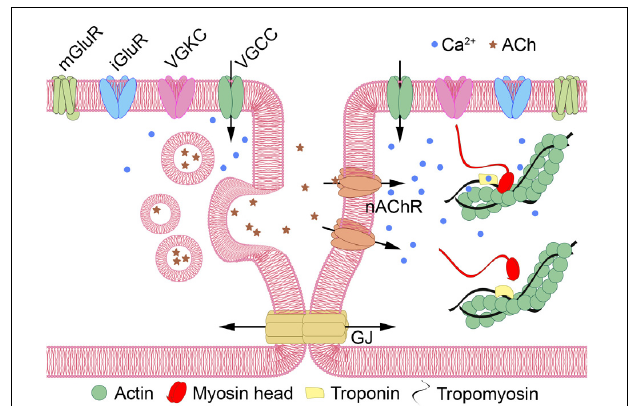
FIGURE 9 | Hypothetical schema of intercellular communication in Dicyemida. Dicyemids have no recognizable neurons and muscles, and yet they have key elements of the neuromuscular system. Metabotropic (mGluRs) or ionotropic glutamate receptors (iGluRs) activate the “presynaptic” cell (left) . Voltage-gated tetrameric calcium (VGCCs) and potassium (VGKCs) ion channels generate propagating action potentials. Ca ++ (blue dots) enters the cytoplasm via VGCCs and triggers the vesicular acetylcholine (ACh, shown by asterisks) release. Activation of nicotinic acetylcholine-like receptors (nAChR) increase Ca ++ level in the “postsynaptic muscular” cell (right) directly or by depolarization of the plasma membrane and VGCC opening. Ca ++ promote contractile elements activation via the Ca ++ dependent troponin-tropomyosin-actin-myosin mechanism. Additional interaction of the two cells can occur via gap junctions